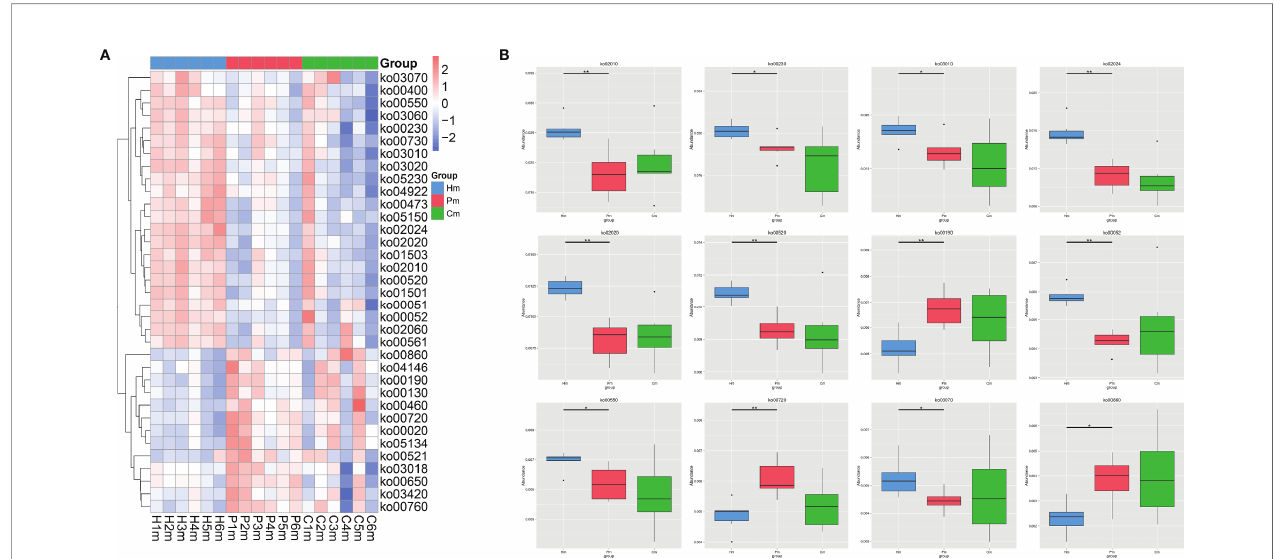
FIGURE 6 | KEGG level 3 pathway annotation according to the genetic data of the oral microbiomes from individuals in the Hm, Cm, and Pm groups. (A) Heatmap of the distribution of the top 35 KEGG pathways at the genus level. (B) Boxplots indicating the relative abundances of the top 12 KEGG pathways (* q -value < 0.05; ** q -value < 0.01; Metastats). Hm, healthy individuals; Pm, patients with periodontitis alone; Cm, patients with Crohn ’ s disease and